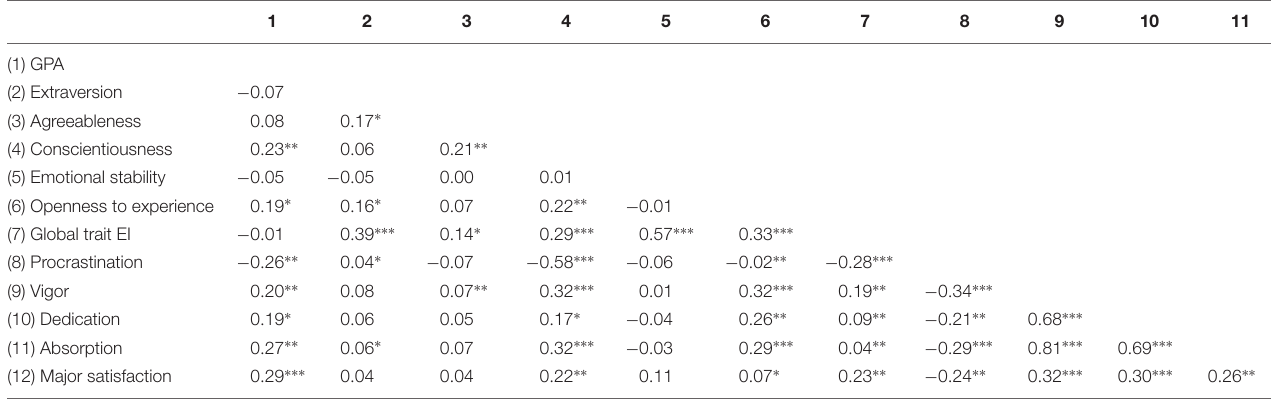
TABLE 1 | Bivariate correlations among study variables ( N = 160).